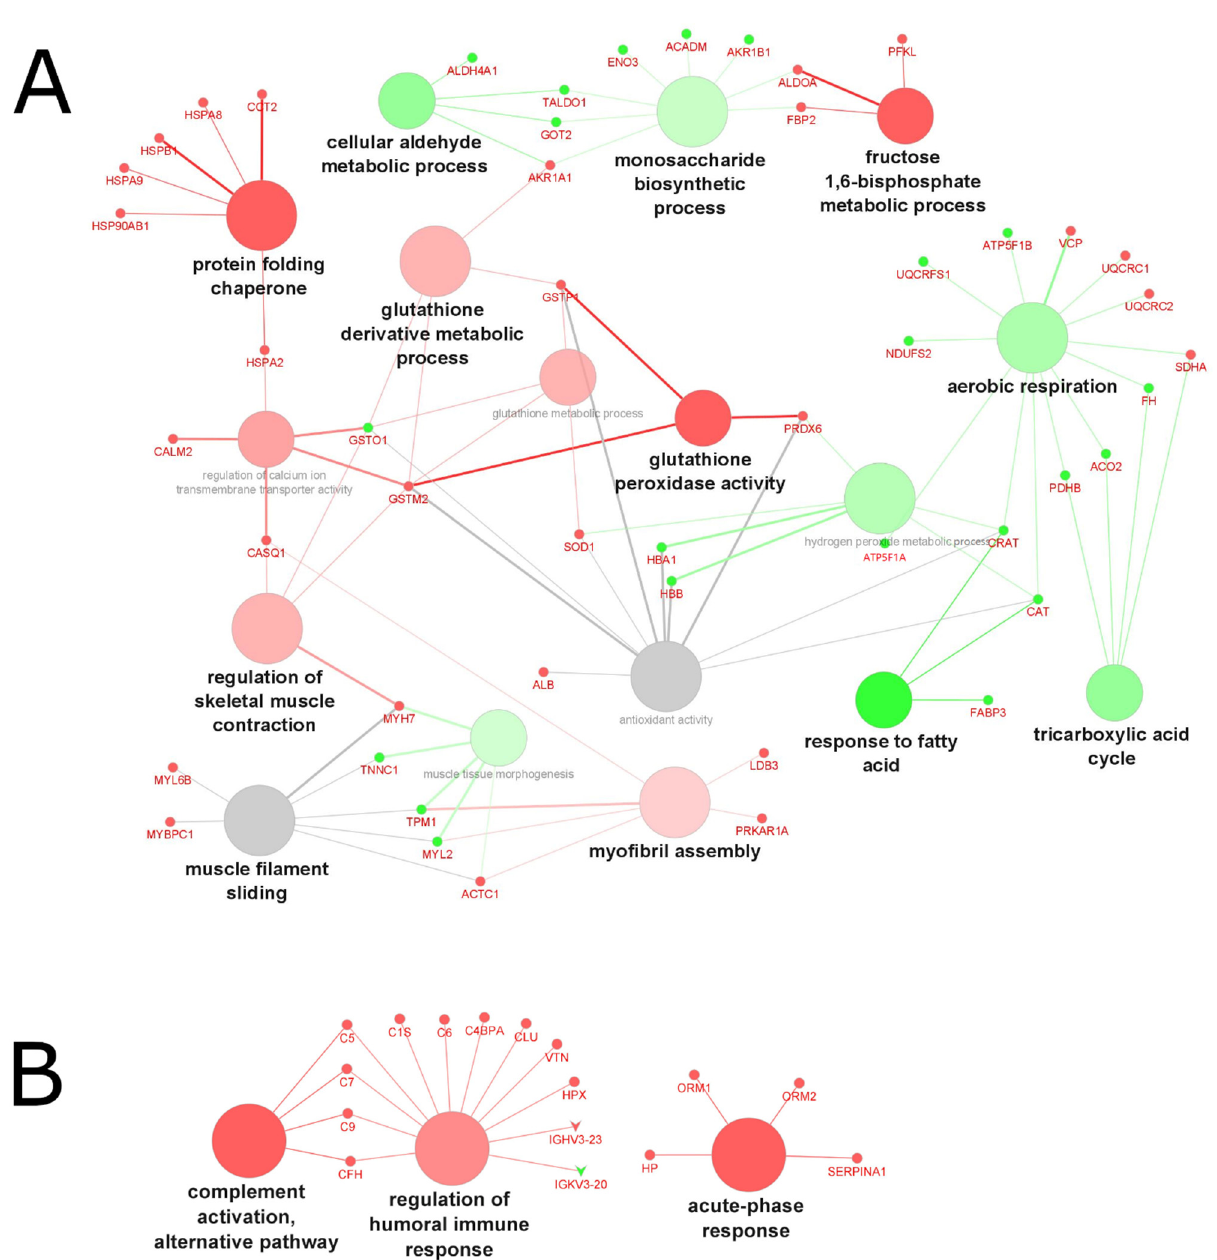
Figure 5. GO analysis of biological processes in aging-related muscle atrophy, based on grouped molecules identified in ( A ) tissue samples and ( B ) biofluid samples from 24 proteomics studies. Red nodes represent upregulated processes, green nodes represent downregulated processes, grey nodes represent common (shared) up- and downregulated processes; font and node sizes reflect statistical significance (kappa score = 0.4 and p -value < 0.01).